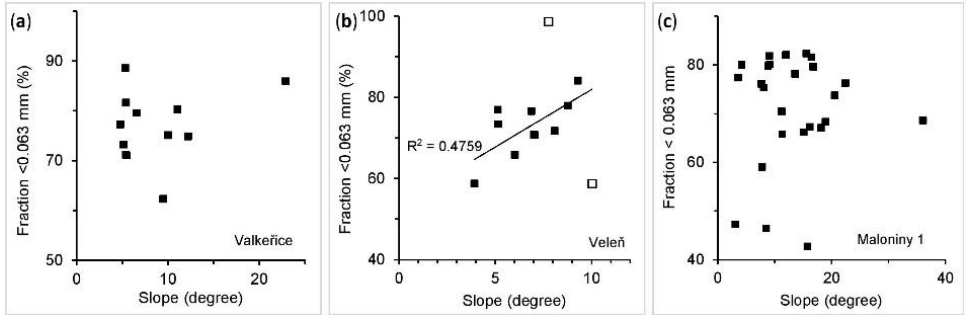
Figure 11. Plots of the content of silt and clay size fractions (<0.063 mm in <2 mm parts) against actual slope at the sampling sites ( a ) Valkeřice, ( b ) Velká Veleň, and ( c ) Maloniny. After excluding two outlying points (empty squares in panel B), the correlation between the fine particle content and slope emerges (full squares were included in correlation) [data sources: soil analysis data].